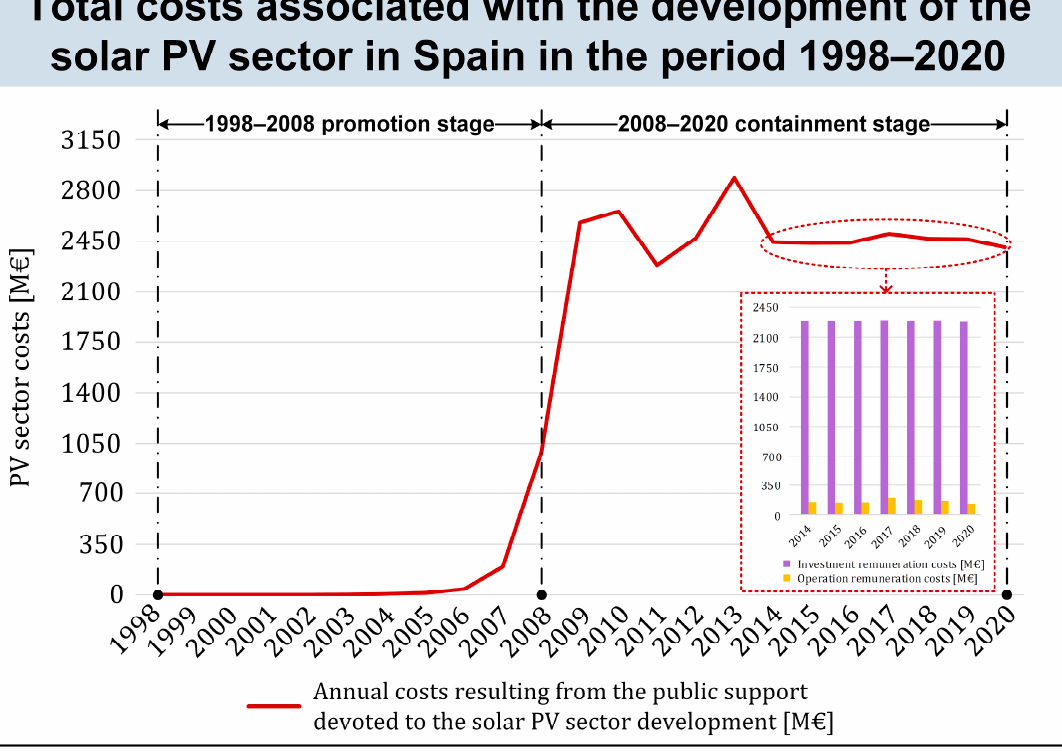
Figure 4. Evolution of the annual costs associated with the Spanish solar PV sector development in the period 1998–2020. Source: self-elaboration based on [69].